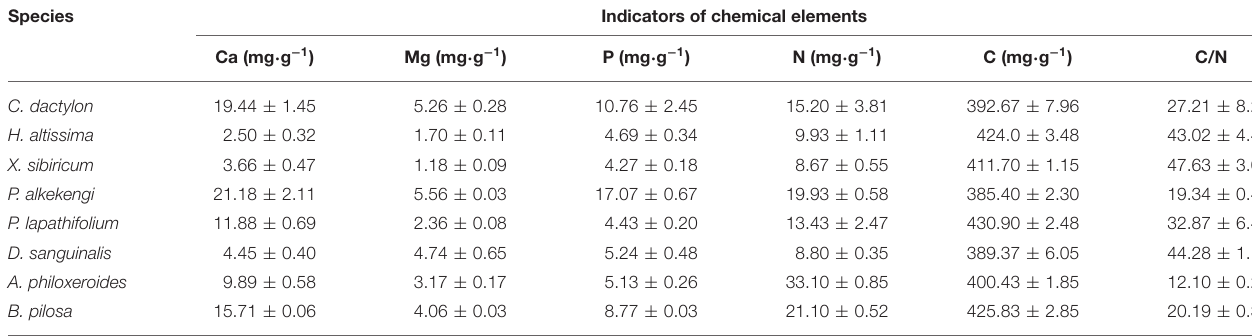
TABLE 3 | The initial elemental content of litter of selected species in the riparian zone of the Three Gorges Reservoir in China. Species